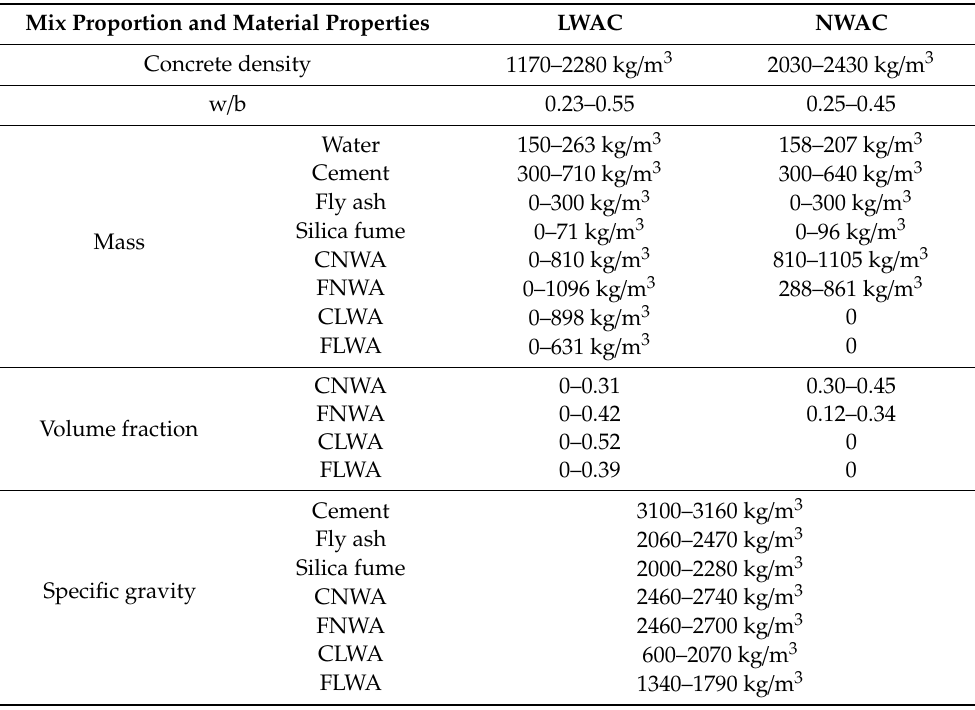
Table 2. Database for ANN